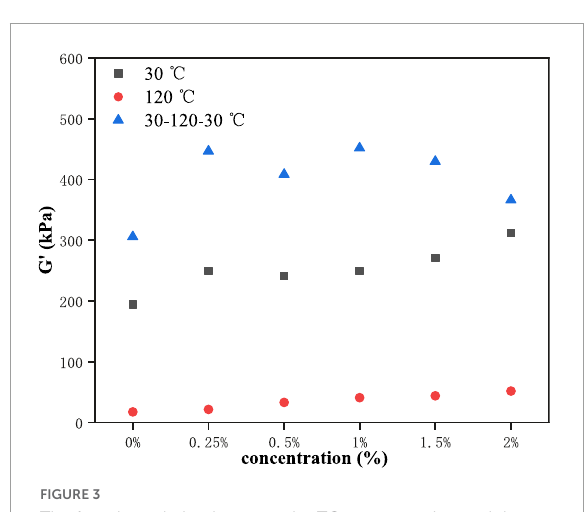
FIGURE3 The function relation between the TG concentration and the value of G' at the end of the LVE